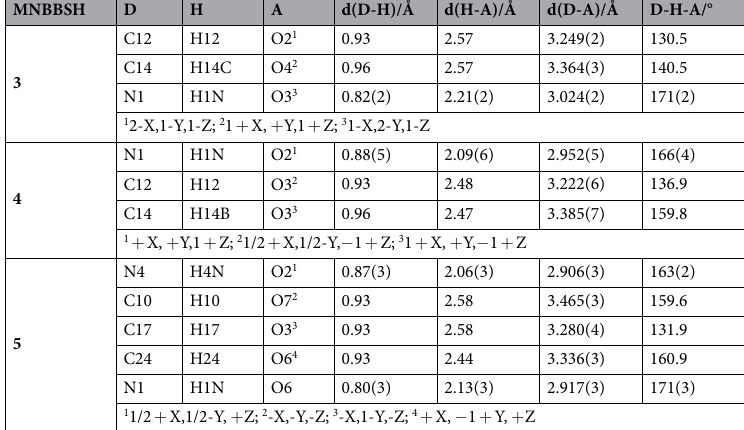
Table 2. Hydrogen bonding of the MNBBSH compounds.